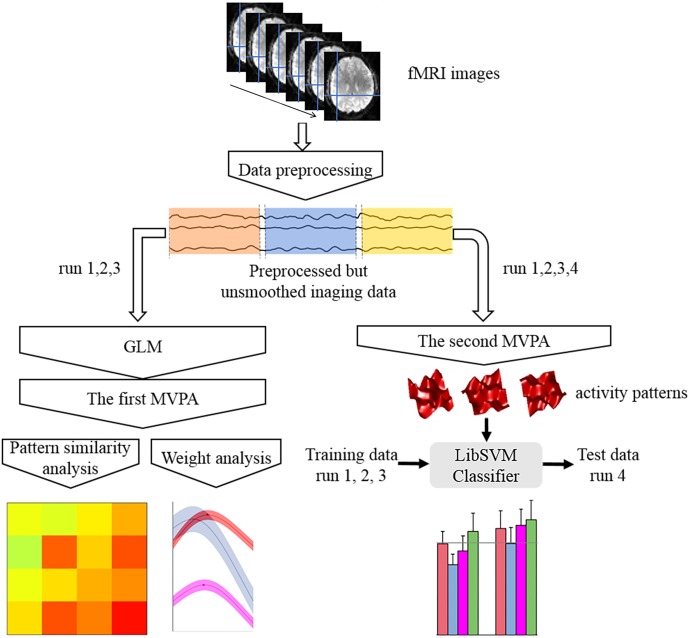
Flow chart of the main analytical steps. There were two kinds of multi-voxel pattern analysis (MVPA) procedures. The results of the first MVPA were applied to pattern similarity analysis and weight analysis, while the results of the second one were used to perform classification analysis.